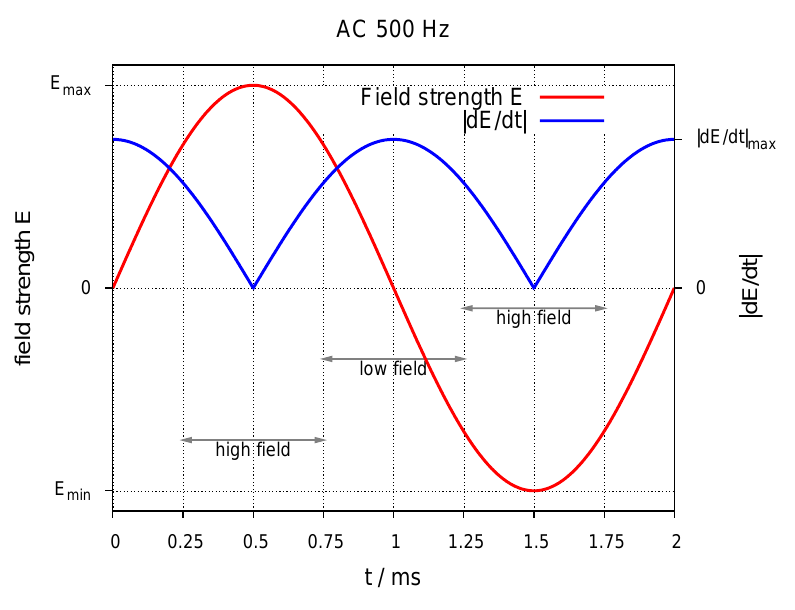
Figure 3 . Time slots in an AC-El cell under typical excitation